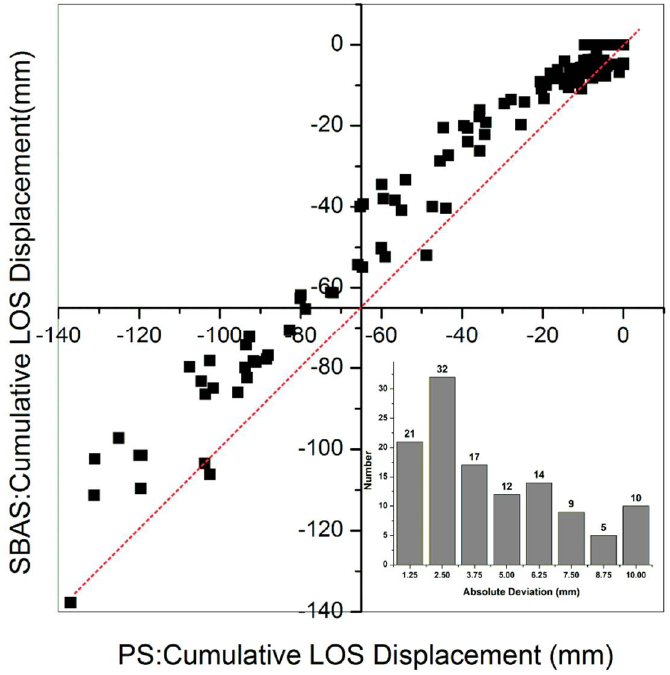
Figure 18. The cumulative LOS displacements of the selected sites: the PS vs. SBAS cross-comparison analysis.